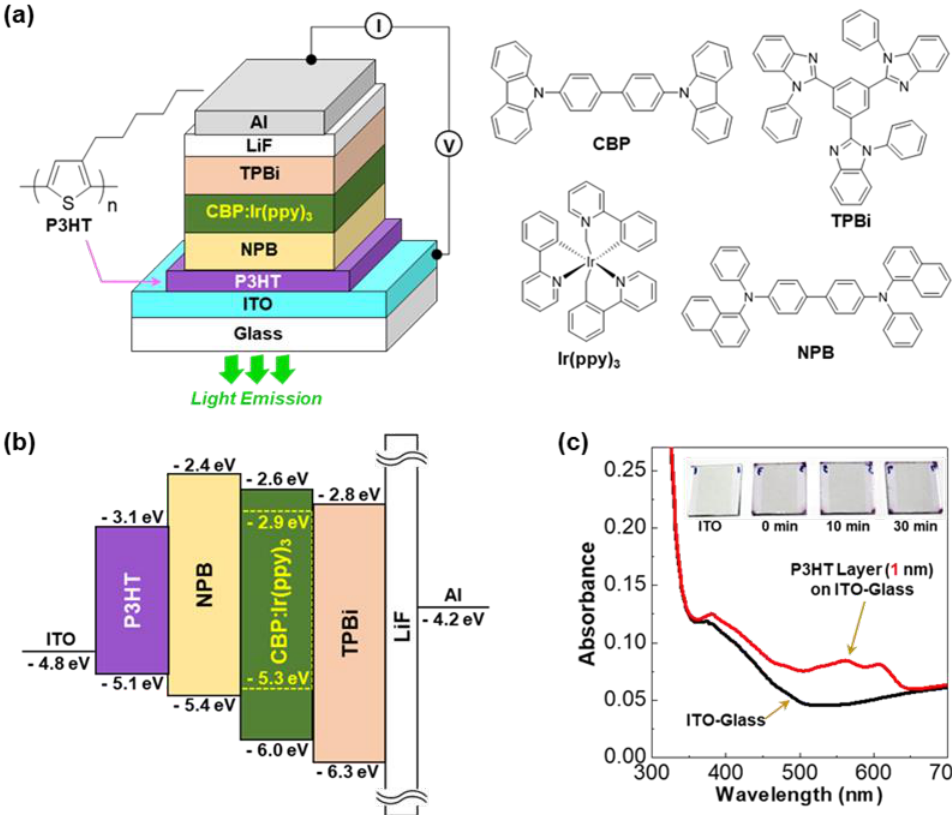
Figure 1. ( a ) Device configuration for the OLED with the P3HT layer and chemical structures. ( b ) Flat energy band diagram of OLED (note that the HOMO and LUMO energy levels of Ir(ppy) 3 in the emission layer were marked as − 5.1 eV and − 2.9 eV, respectively). ( c ) Optical absorption spectra for ITO-glass (black lines) and P3HT layer-coated ITO-glass (red line) (see inset photographs).